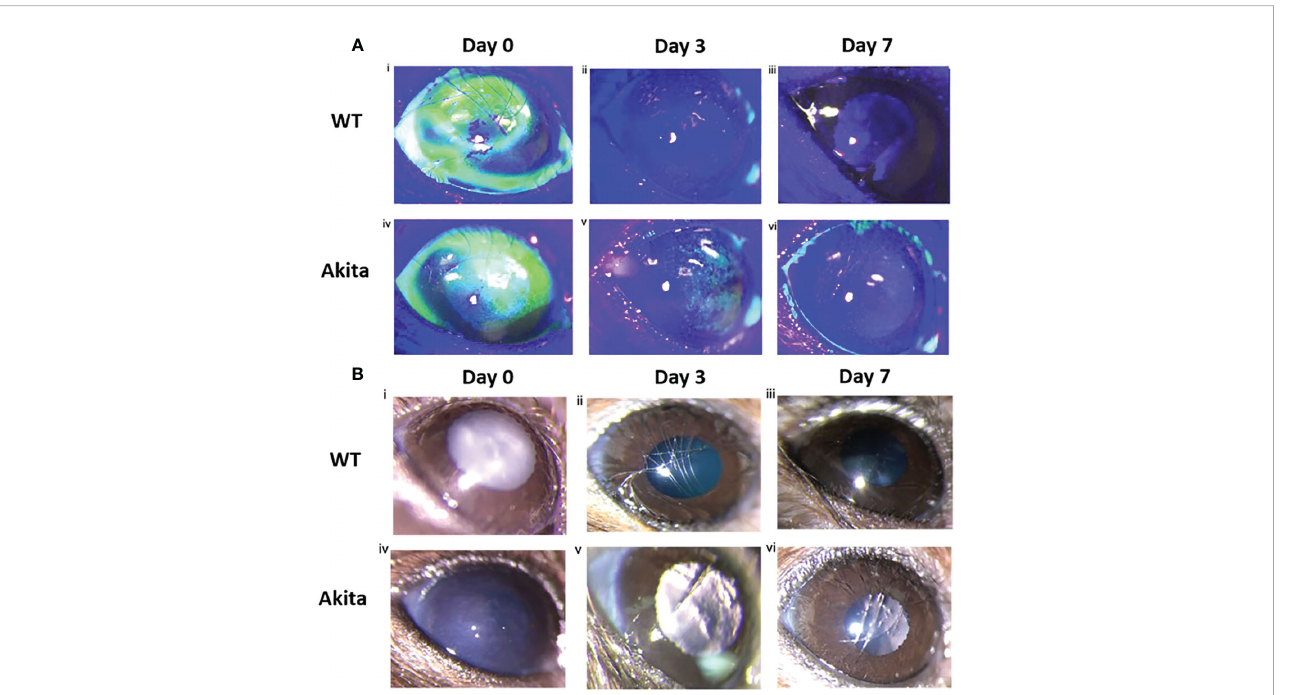
FIGURE 2 Wound healing analysis for WT and Akita mice with slit lamp images. (A) Injured cornea from WT and Akita mice at days 0, 3, and 7 after injury using 0.1 M NaOH and 10 s injury time, with fl uorescein stain under cobalt blue light. Photos of the corneas taken immediately after injury showed signi fi cantly impaired corneal epithelium for both WT and Akita mice. (i, iv) The cornea from WT mouse was fully re-epithelized at day 3 after injury (ii); the cornea from Akita mouse was not fully re-epithelized at day 3 (v) and day 7 (vi) after injury. Magni fi cation:40×. (B) Bright- fi eld images of the right (injured) cornea from WT and Akita mice taken at day 0 (i, iv), day 3 (ii, v), and day 7 (iii, vi) after corneal alkaline injury ( n = 55 in WT, n = 55 in Akita).